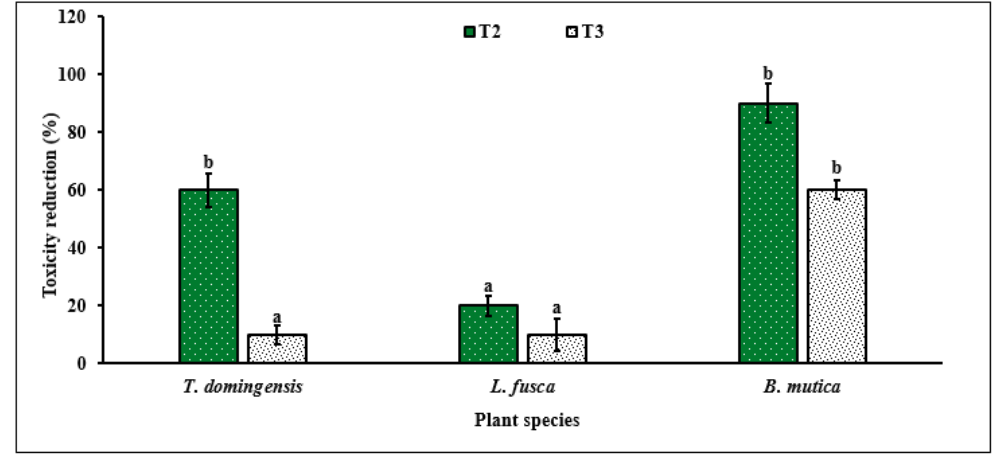
Figure 4. Relative performance of di ff erent plant species in toxicity reduction of tannery e ffl uent